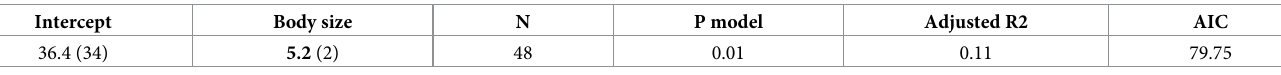
Table 3. GLM model that presented the best adjustment to explain the distance to the nearest neighbor (DNN) in both sexes during the non-breeding season with data obtained in Survey 2. Model intercept and explanatory variable are expressed as Mean (SD). For each parameter the value is shown in bold if statistically significant (p <